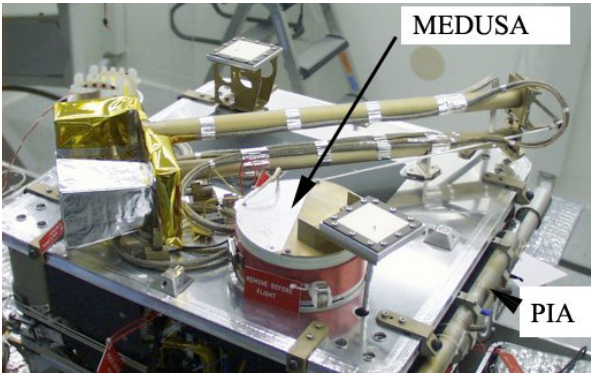
Fig. 2b. MEDUSA mounted on the top, antisunward facing plat- form of Astrid-2. The aperture is covered by a remove-before-flight band with a nitrogen purge port. A square S-band patch antenna is mounted on top of MEDUSA. The stand for the S-band antenna, located in the opposite corner of the top platform, reflects light dur- ing some circumstances into electron sector 15. MEDUSA is tilted 3 ◦ , with the highest point looking across the top platform diagonal. Also seen here is the magnetometer and ASC-boom in its stowed position, and the PIA-1/2 assembly on one of the sides of the satel- lite